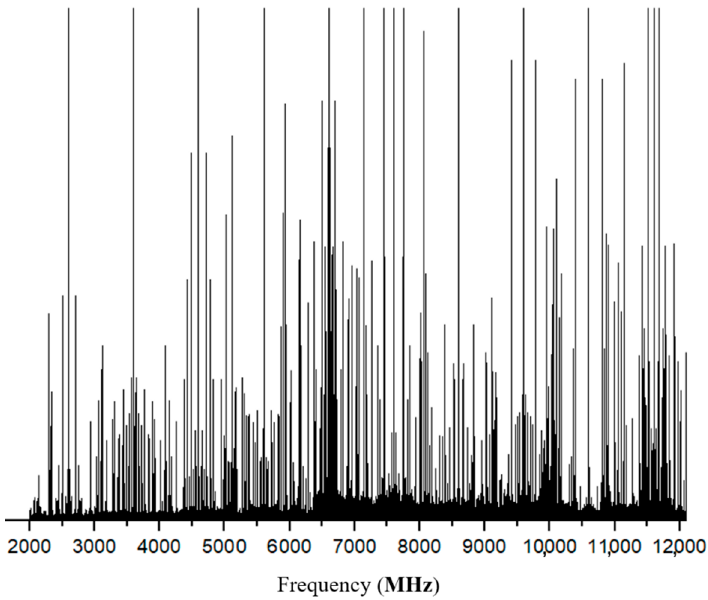
Figure 2. Experimental spectrum of benzophenone in the 2–12 GHz range.